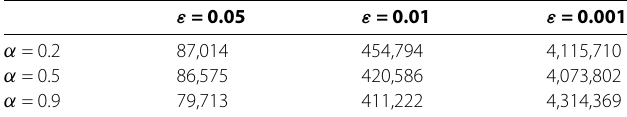
Table 2 The posteriori regularization parameter m under different α and ε for Example 2 ε = 0.05 ε = 0.01 ε = 0.001 α = 0.2